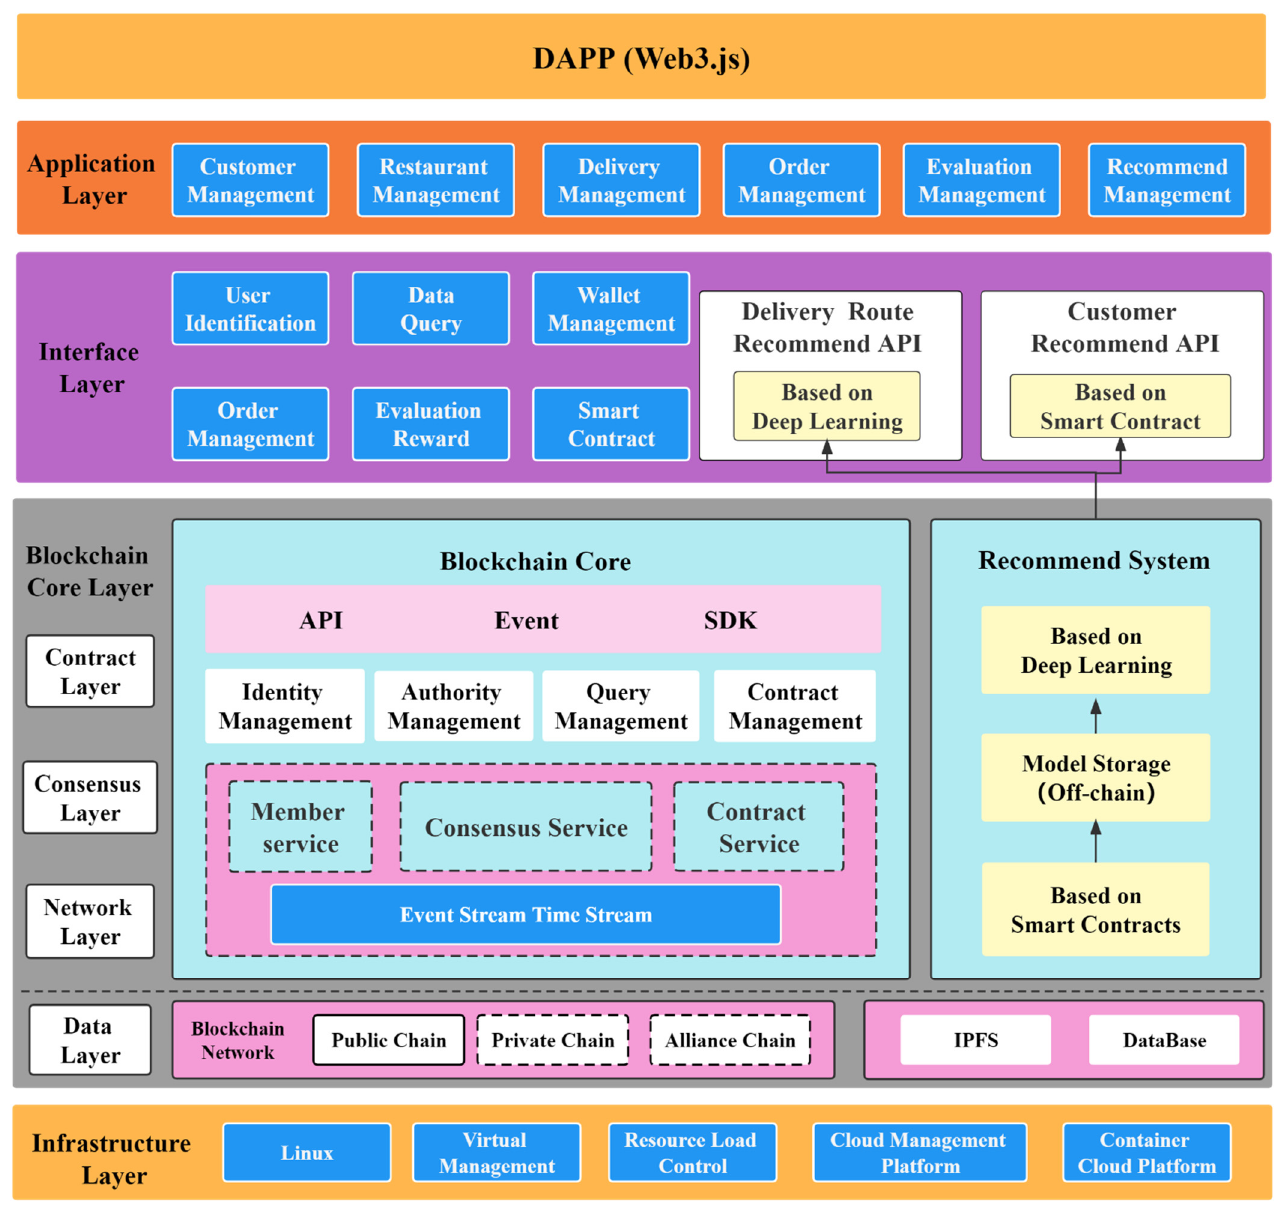
Figure 5. Blockchain takeaway platform architecture plan.